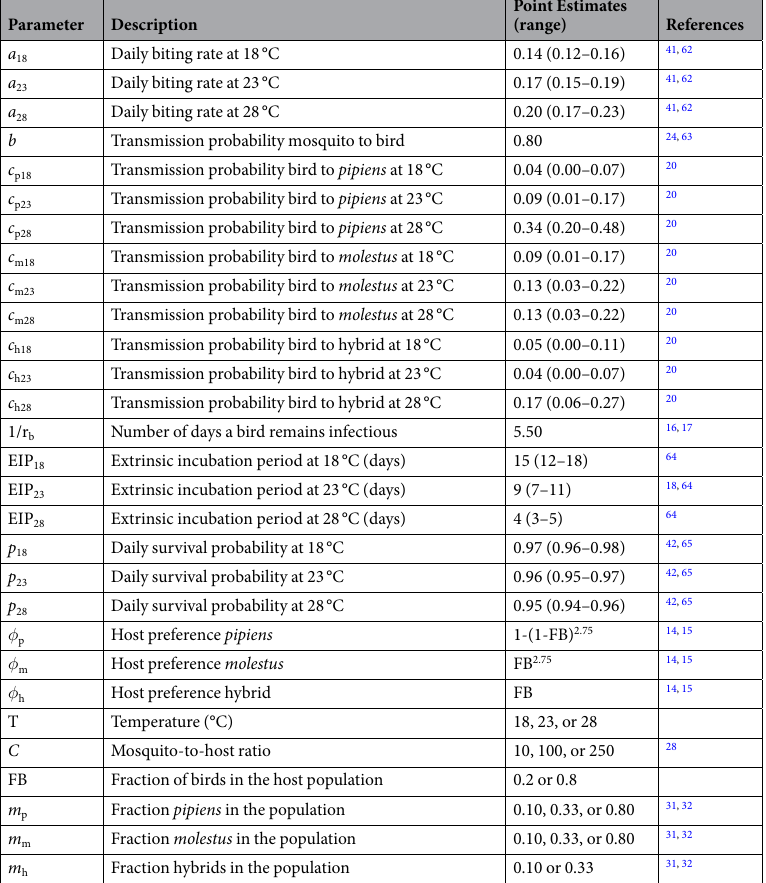
Table 1. Parameter estimates for basic reproduction number ( R 0 )